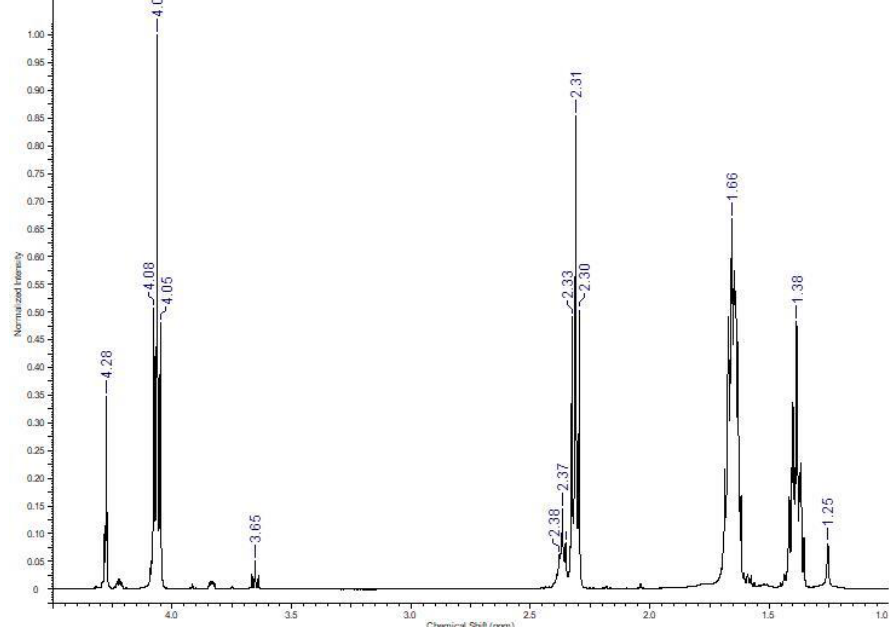
Figure 5. 1 H NMR spectrum of PCL 5000 -PEA 2500 -PCL 5000 sample in CDCl 3.